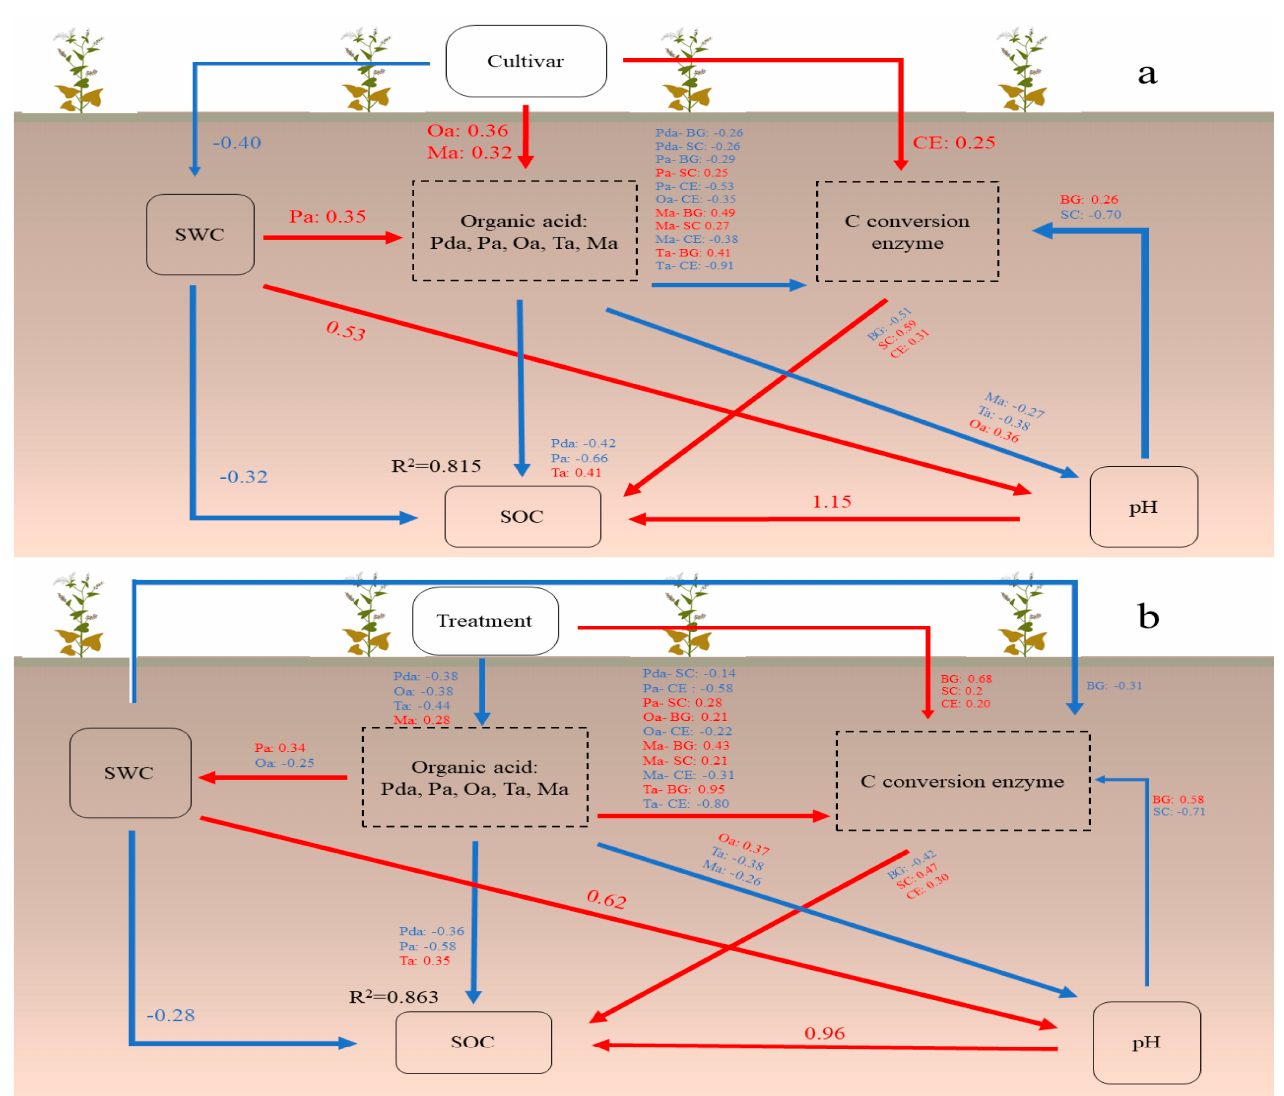
Figure 7. Structural equation model (SEM) of different Tartary buckwheat cultivars and treatment in ( a ) (x 2 = 33.787, df = 29, p = 0.247, CFI = 0.988, GFI = 0.911, RMSEA = 0.056) and ( b ) (x 2 = 37.805, df = 26, p = 0.063, CFI = 0.974, GFI = 0.907, RMSEA = 0.093). Rectangles represent observed variables, arrow thickness represents the magnitude of the path coefficient. The Red and blue lines represent positive and negative effects between the observed variables. SOC, soil organic carbon; SWC, soil water content; Pda, malonic acid; Pa, propionic acid; Oa, oxalic acid; Ta, tartaric acid; Ma, malic acid. BG, β− glucosidase; SC, sucrase enzyme; CE, celluase enzyme.